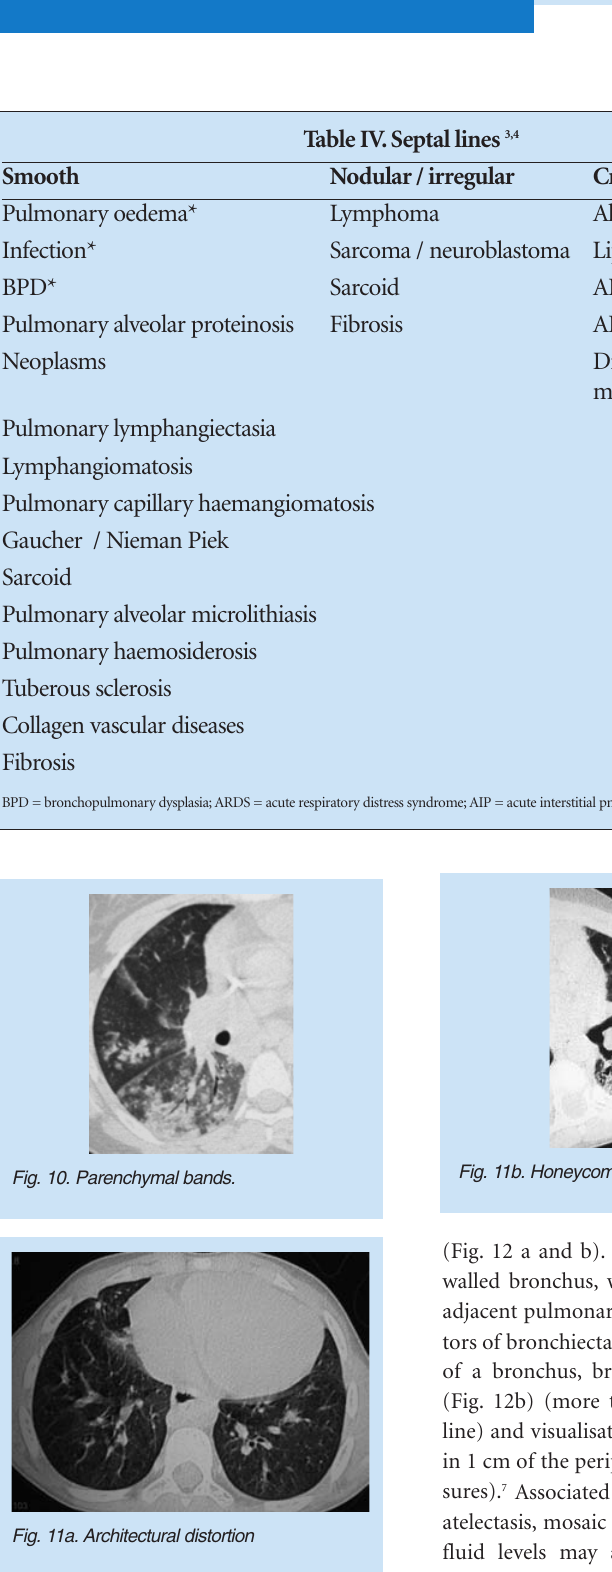
Fig.12b. Bronchial wall thickening and ‘signet ring